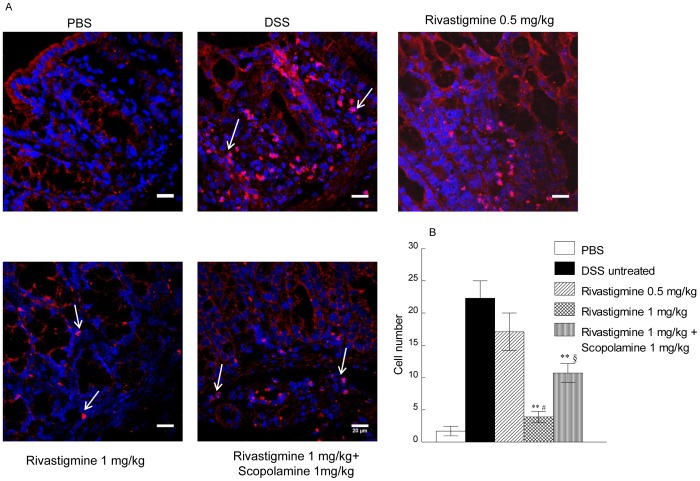
Effect of rivastigmine with and without scopolamine on CD11b+ cell infiltration in DSS-induced colitis.A: Immunofluorescence stained mouse tissue sections showing CD11b (red) cells. White arrows show cells which express with CD11b+ in colitis tissue (pink). B: Quantification of the pink CD11b+ expressing cells (ImageJ) in the samples of mice colon sections. Data represent the mean ± SEM from three slides per animal, 6 animals per group; scale bar 20 µm. Significantly different from mice with DSS-induced colitis treated with PBS, **p<0.01; significantly different from mice treated with rivastigmine (0.5 mg/kg), # p<0.05; significantly different from mice treated with rivastigmine (1 mg/kg), §
p<0.05.